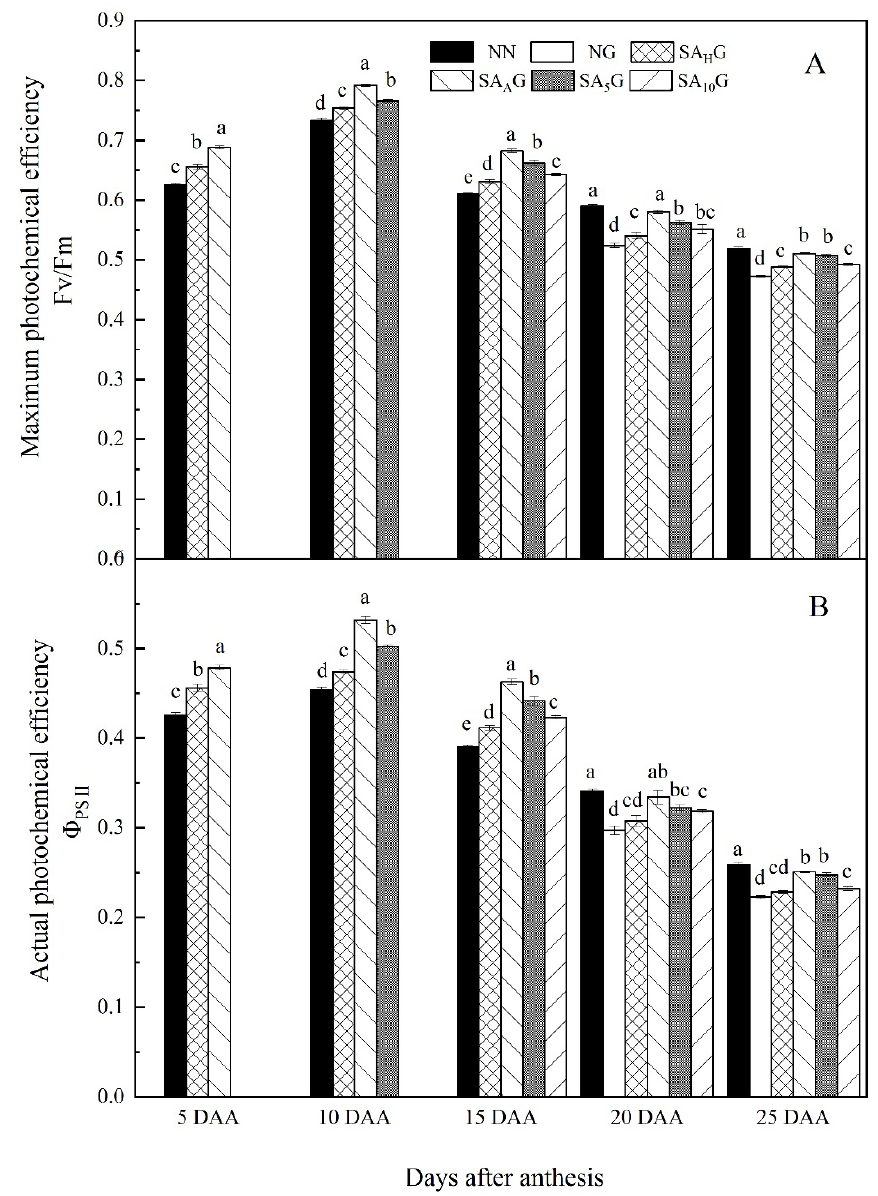
Figure 5. Effects of exogenous salicylic acid (SA) spraying on the maximum photochemical efficiency ( A ) and actual photochemical efficiency ( B ) of the flag leaves under high temperature stress during the grain-filling period in 2018–2019. NN is the control (normal growth conditions outside the shed). NG represents non-SA spraying and high temperature stress at the grain-filling stage. SA H G represents exogenous SA spraying at the heading stage and high temperature stress at the grain-filling stage. SA A G represents exogenous SA spraying at the anthesis stage and high temperature stress at the grain-filling stage. SA 5 G and SA 10 G represent treatments whereby exogenous SA was sprayed starting from 5 and 10 DAA and high temperature stress at the grain-filling stage. Different lowercase letters denote statistically significant differences ( p < 0.05, Duncan’s multiple range test) among treatments. Results are expressed as mean ± SE ( n = 3).